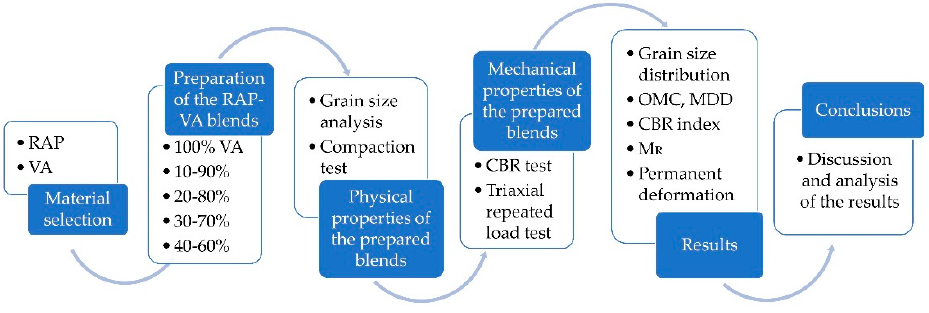
Figure 2. Research